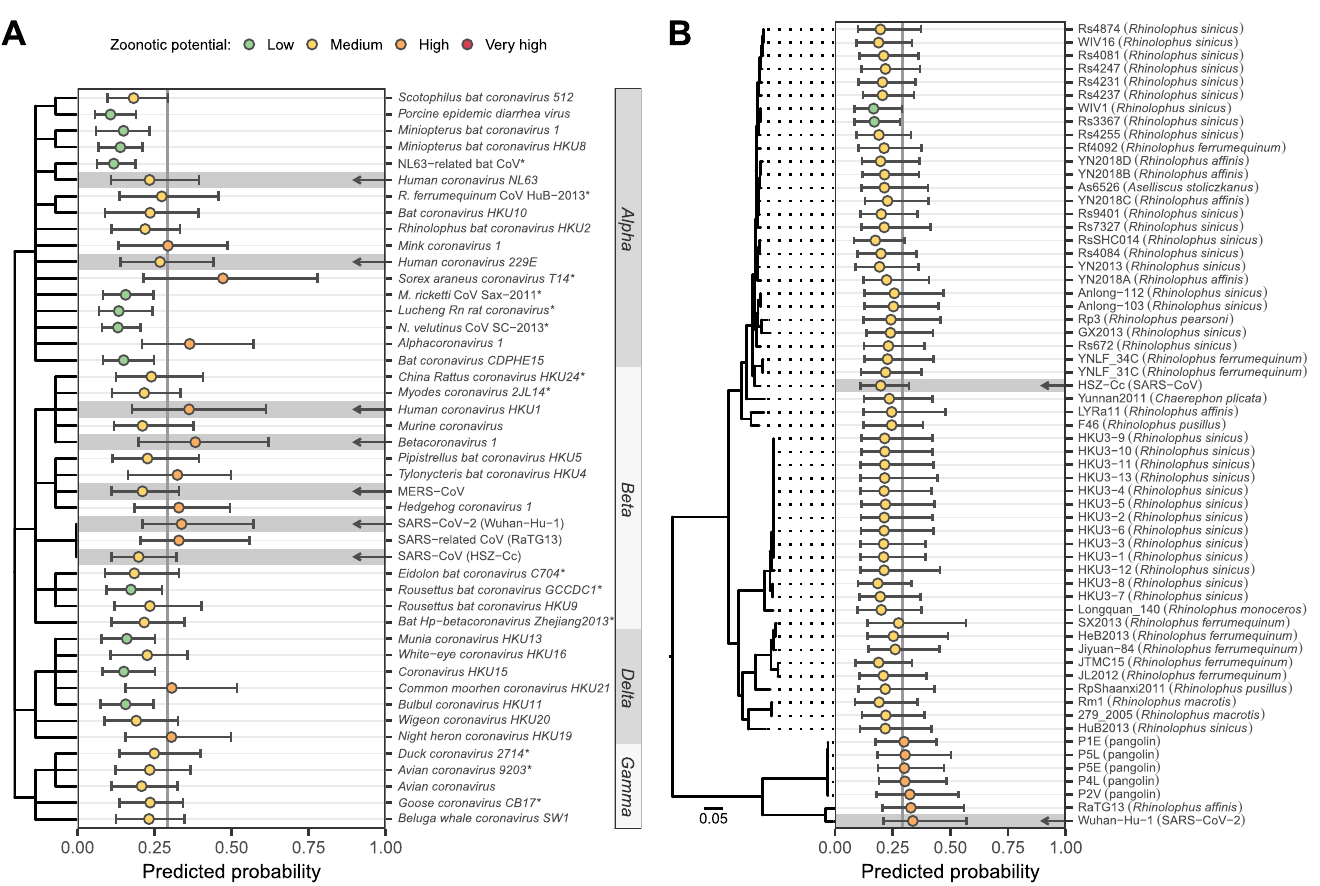
Fig 5. Probability of human infection predicted from coronavirus genomes. (A) Predictions for currently recognized Coronaviridae species and for 3 variants of SARS-related coronavirus: SARS-CoV (isolate HSZ-Cc, sampled early in the 2003 pandemic), SARS-CoV-2 (isolate Wuhan-Hu-1, sampled early in the current pandemic), and the closely related RaTG13 (sampled from Rhinolophus affinis in 2013). A dendrogram illustrates taxonomic relationships, with abbreviated genus names annotated on the right. Arrows highlight known human-infecting species. Asterisks indicate species absent from the training data, also present in Fig 3A. (B) Predictions for different representatives of SARS-related coronavirus. The isolation source of animal-associated genomes is indicated in parentheses. A maximum likelihood phylogeny illustrates relationships and was created as described in [6]. The outgroup, BtKy72 (sampled in Kenya in 2007), is not shown. In both panels, bars show the 95% interquartile range of predicted probabilities across the best performing 10% of iterations excluding the species being predicted, while circles show the mean predicted probability from these iterations. Numerical data underlying this figure can be found in S1 Table (panel A) and at https://github.com/nardus/zoonotic_ rank/tree/main/FigureData (panel B; doi: 10.5281/zenodo.4271479). MERS-CoV, Middle East Respiratory Syndrome–related Coronavirus ; M . ricketti CoV Sax-2011, Myotis ricketti alphacoronavirus Sax-2011 ; NL63-related bat CoV, NL63-related bat coronavirus strain BtKYNL63-9b ; N . velutinus CoV SC-2013, Nyctalus velutinus alphacoronavirus SC-2013 ; R . ferrumequinum CoV HuB-2013, Rhinolophus ferrumequinum alphacoronavirus HuB- 2013; SARS, Severe Acute Respiratory Syndrome; SARS-CoV-2, Severe Acute Respiratory Syndrome Coronavirus